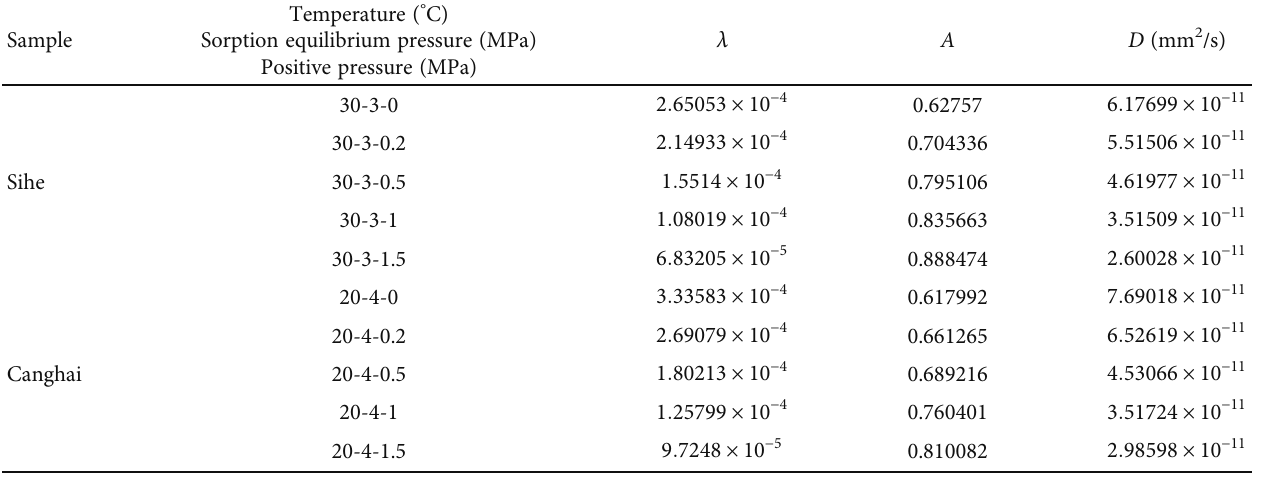
Table 5: Calculation results for λ , A , and D .